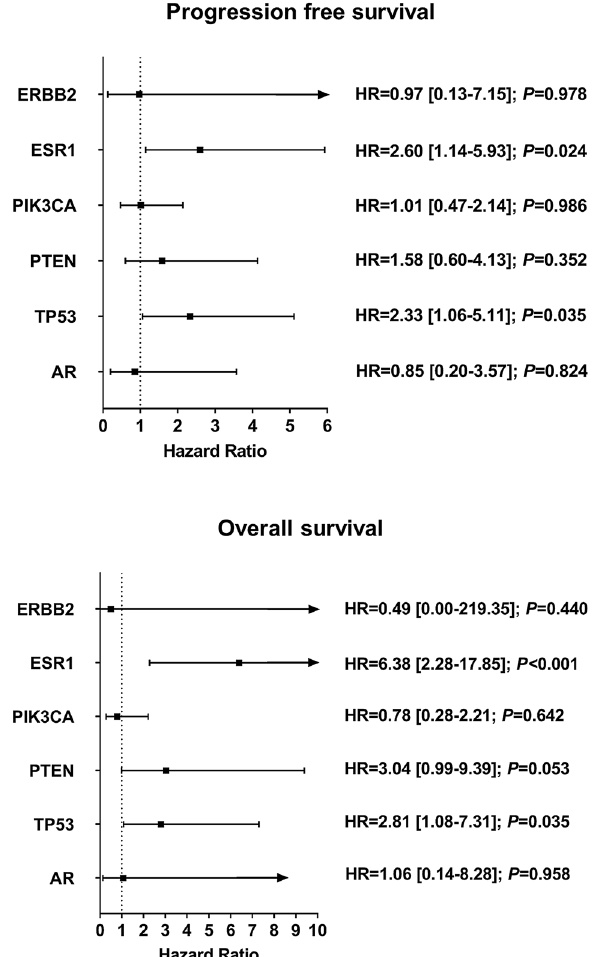
Figure 2. Hazard ratios [95% confidence interval] of mutated genes for progression free survival and overall